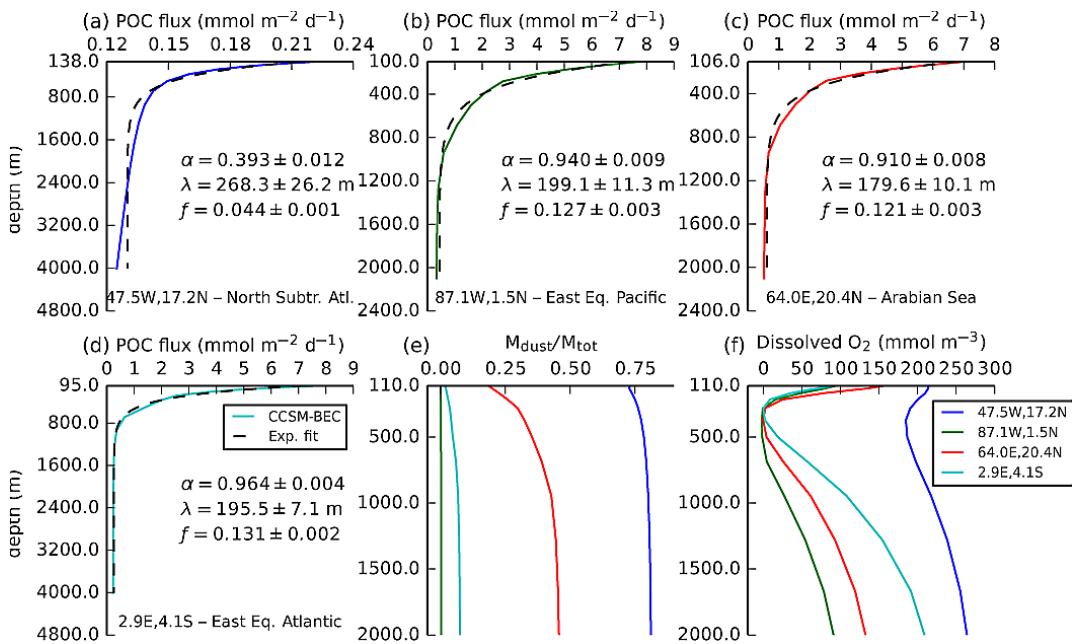
Fig. 7. (a–d) show vertical profiles of POC flux at the locations marked in Fig. 5 where the errors for the exponential model are relatively large compared to the rest of the global ocean. The solid lines represent the POC flux from CCSM–BEC, and the dashed lines show the exponential fit (Eq. 1). The estimated values of α , λ and f and their 95% confidence intervals are also shown for each location. (e) and (f) show the mass flux ( M ) ratio (gm − 2 d − 1 /gm − 2 d − 1 ) of sinking dust to total particulate sinking material and dissolved oxygen from CCSM-BEC, respectively, at the same locations shown in (a–d) . The color of the solid lines corresponds to the color of the circles marking the location of the profiles in Fig.